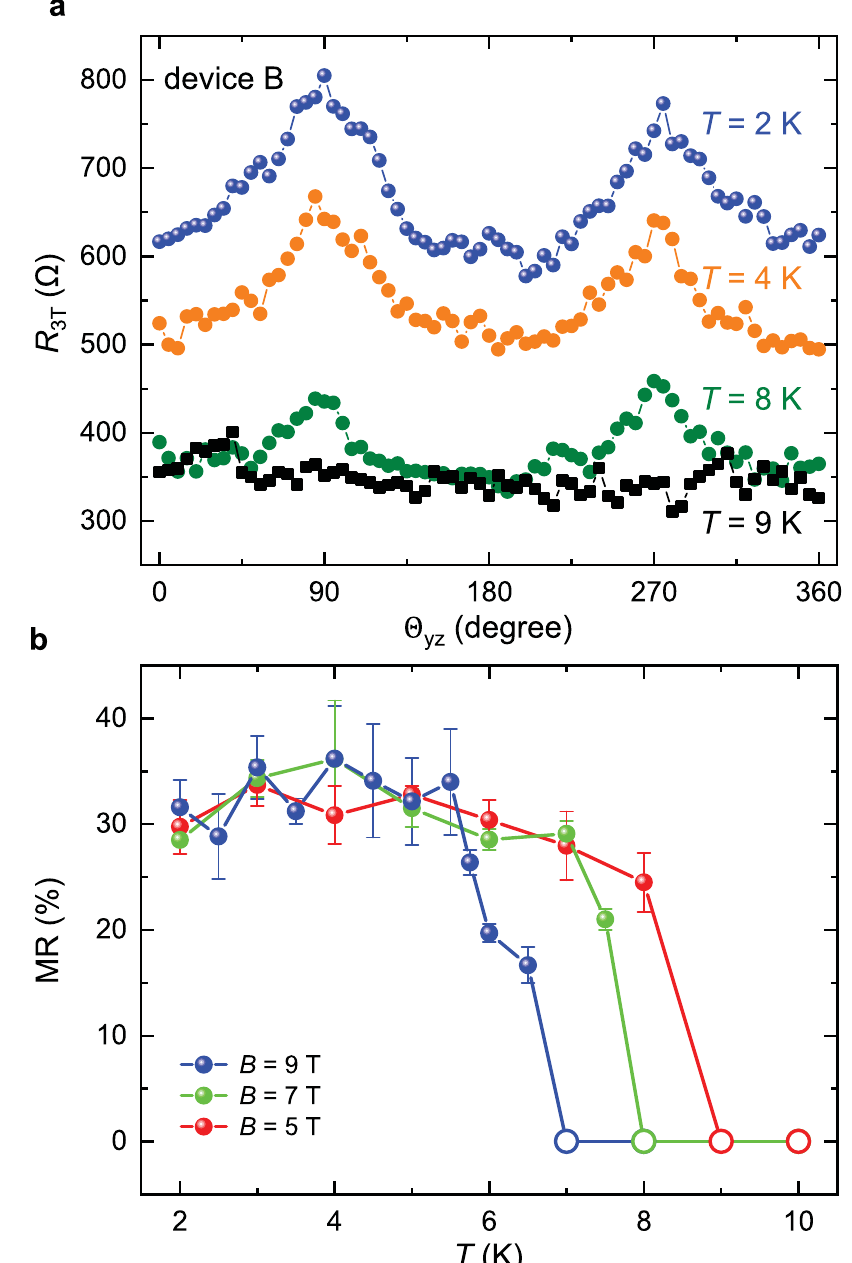
Fig. 3 The temperature dependence of MR at Fe 0.29 TaS 2 /SC interface. a The interfacial resistance as a function of Θ yz measured on device B at T = 2 K (blue), 4 K (yellow) 8 K (olive), and 9 K (black), respectively. These results were obtained under B = 5 T and V bias = 1 mV, which correspond to V 3T ~ 0.40 mV for T = 2 and 4 K, and V 3T ~ 0.25 mV for T = 8 and 9 K. b The temperature dependence of MR ratio of device B at B = 9 T, 7 T, and 5 T, respectively. The error bars correspond to one standard deviation. The open circles represent the absence of obvious